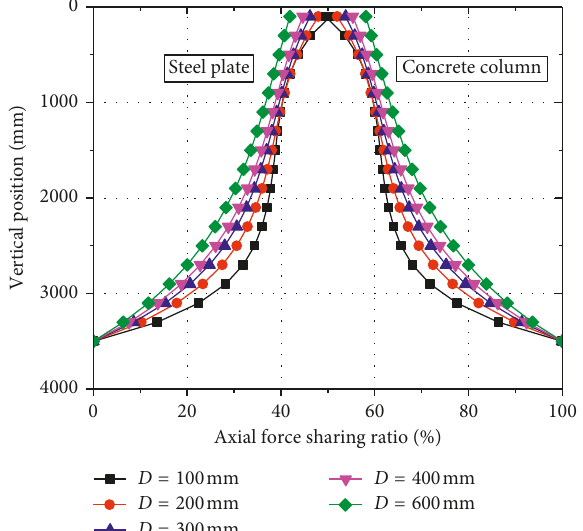
Figure 18: Effect of the connector spacing on the shear force